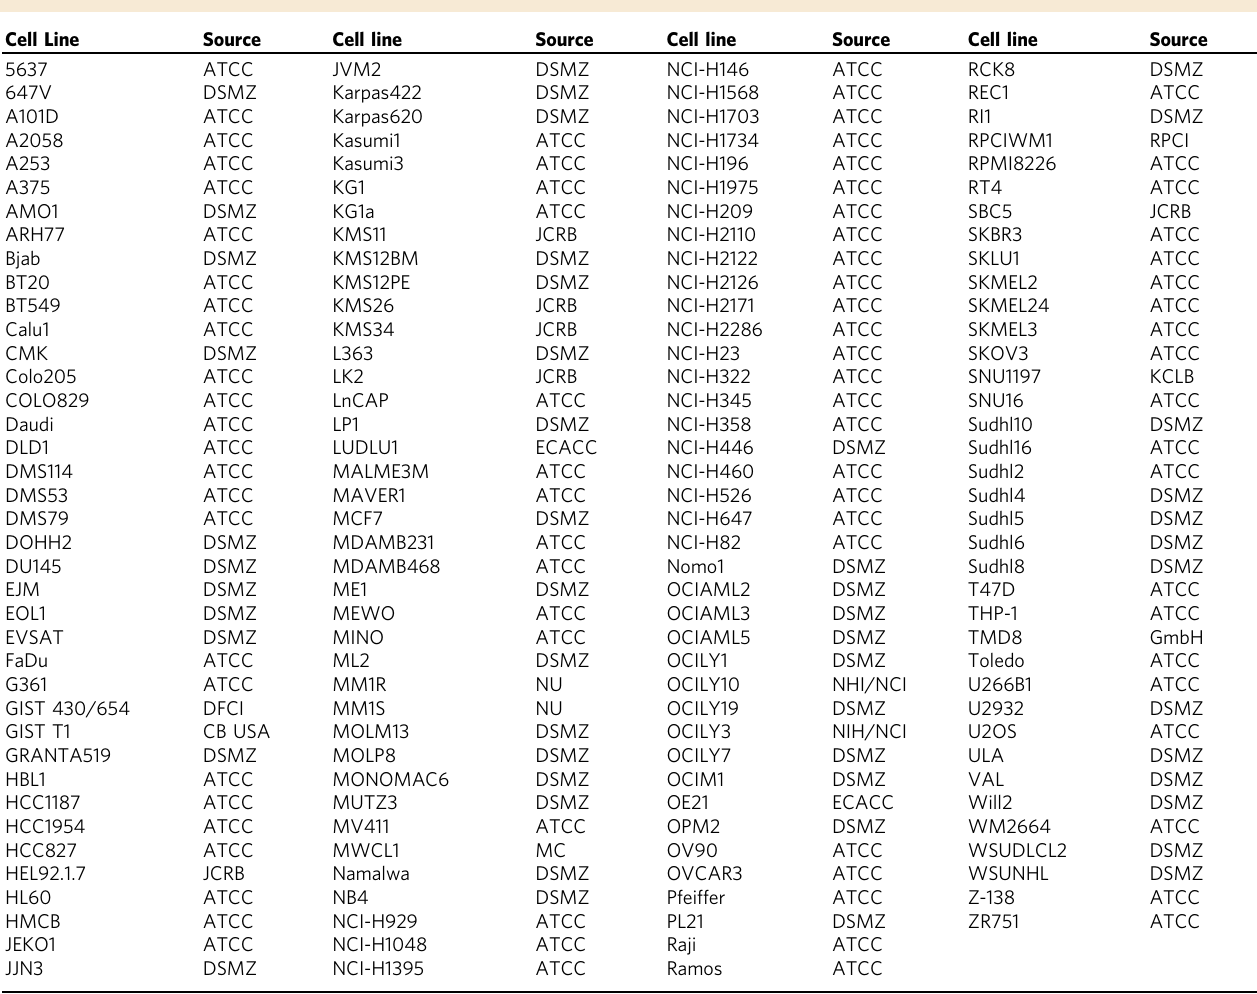
Table 3 List and origin of cell lines used in these studies Cell